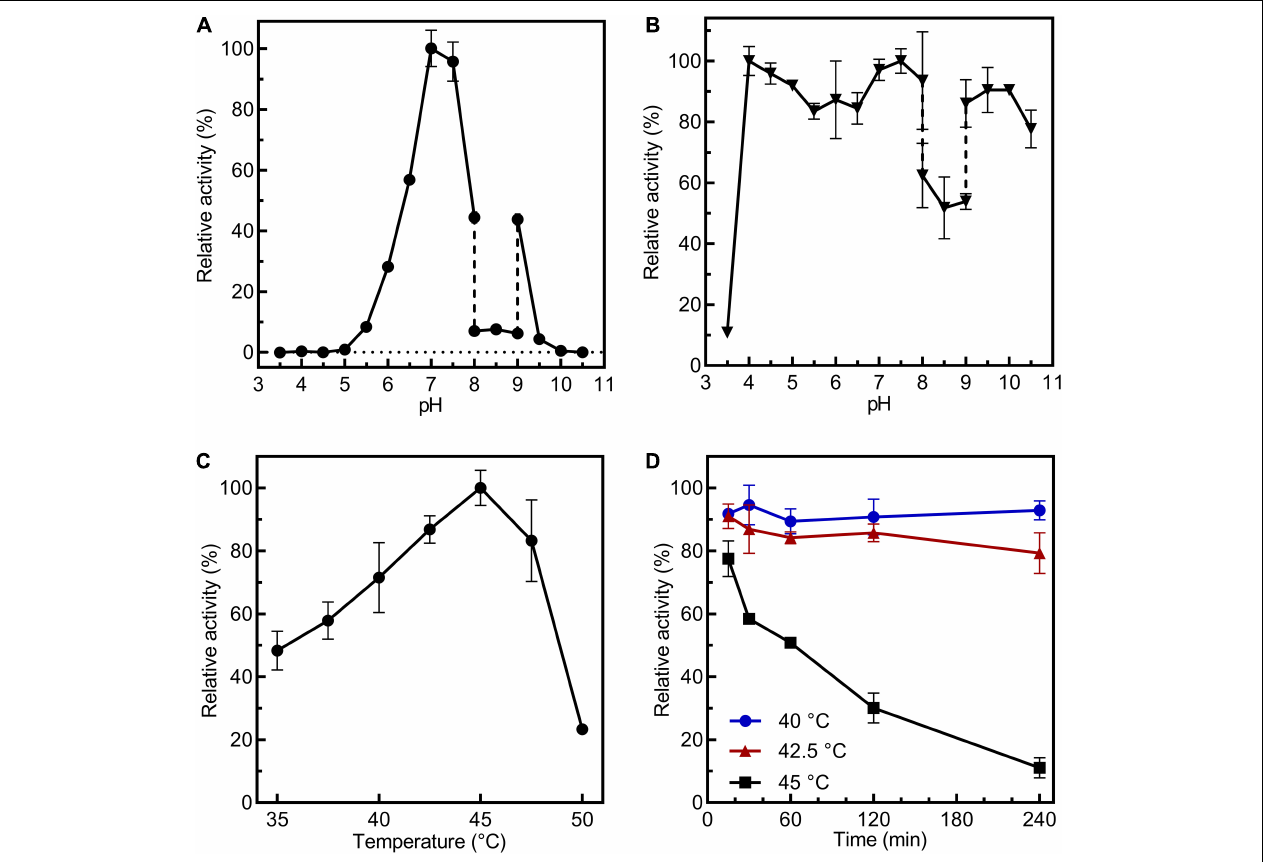
FIGURE 2 | Biochemical characterization of Cs BGL. (A) Measurements of optimum pH of Cs BGL. Reactions were performed at 45 ◦ C for 5 min at various pH values from 3.5 to 10.5 using p NP- β -Glc as substrate. (B) Measurements of pH stability of Cs BGL. The Cs BGL was incubated in the presence of various pH values